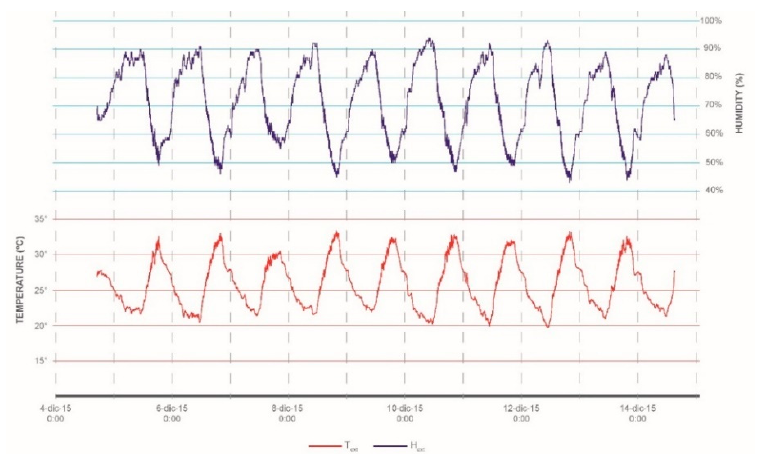
Figure 5. Hygrothermal data in Santiago de Cali, 4–15 December. Source: Solar Decathlon staff.